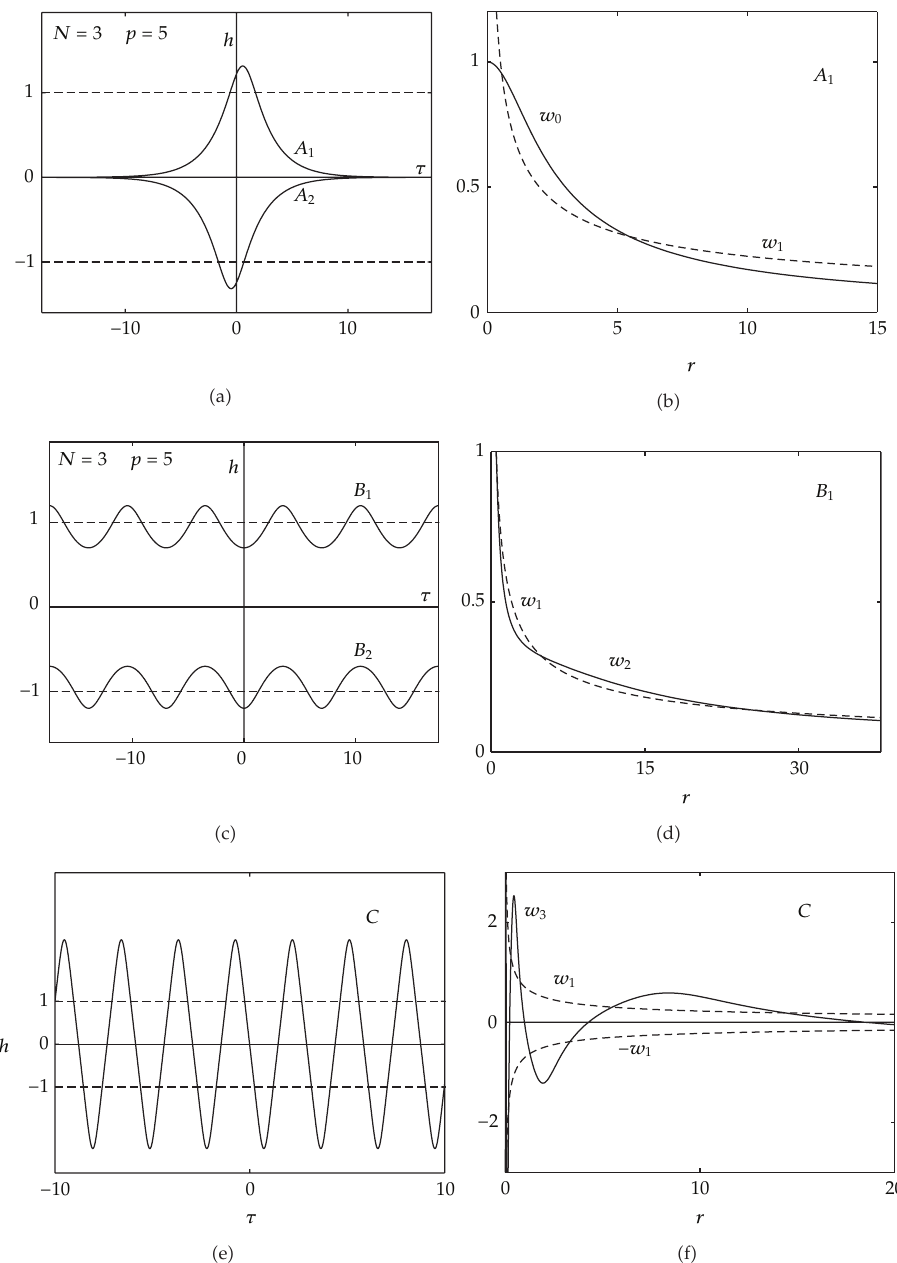
Figure 3: Critical case: N (cid:5) 3, p (cid:5) 5. (cid:6)(cid:6) a (cid:7) , (cid:6) c (cid:7) , and (cid:6) e (cid:7)(cid:7) Homoclinic and periodic orbit solutions of (cid:6) 3.2 (cid:7) proved in Theorem 3.1. (cid:6)(cid:6) b (cid:7) , (cid:6) d (cid:7) , and (cid:6) f (cid:7)(cid:7) The corresponding solutions of (cid:6) 3.1 (cid:7) proved in Theorem 3.2: √ (cid:6) r (cid:7) (cid:5) 1 / w 2 r is the known singular solution, w 2 (cid:6) r (cid:7) is a new positive singular solution, and w 3 (cid:6) r (cid:7) is a 1 new sign changing singular